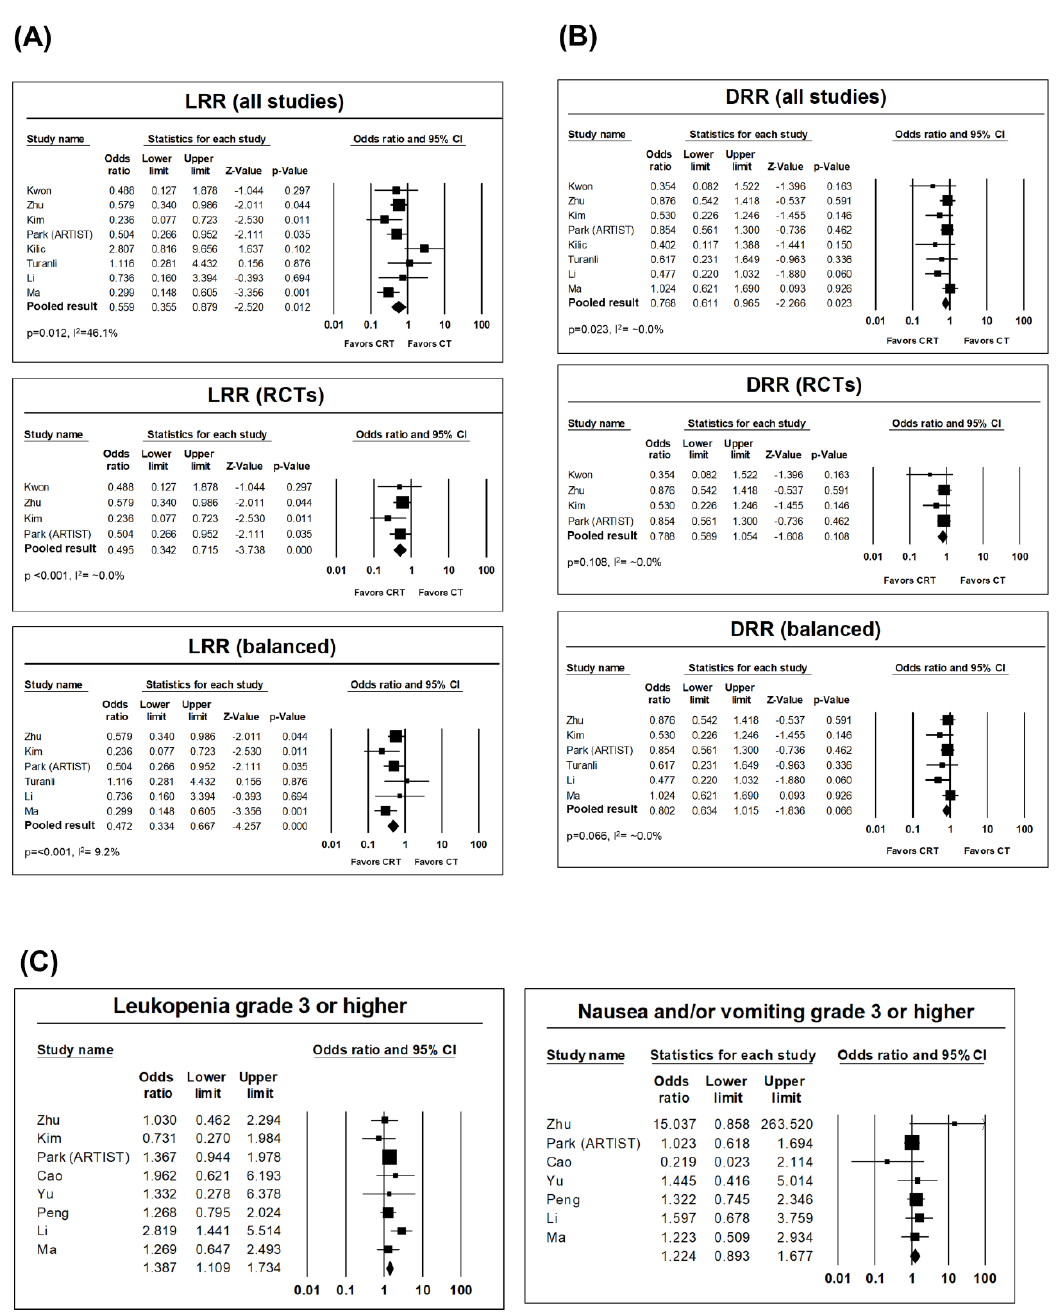
Figure 3. ( A ) Forest plots of overall and subgroup pooled analyses of locoregional recurrence rate (LRR). ( B ) Forest plots of overall and subgroup pooled analyses of distant recurrence rate (DRR). CI, confidence interval; RCT, randomized controlled trial. ( C ) Forest plots of pooled analyses of leukopenia and nausea and/or vomiting.